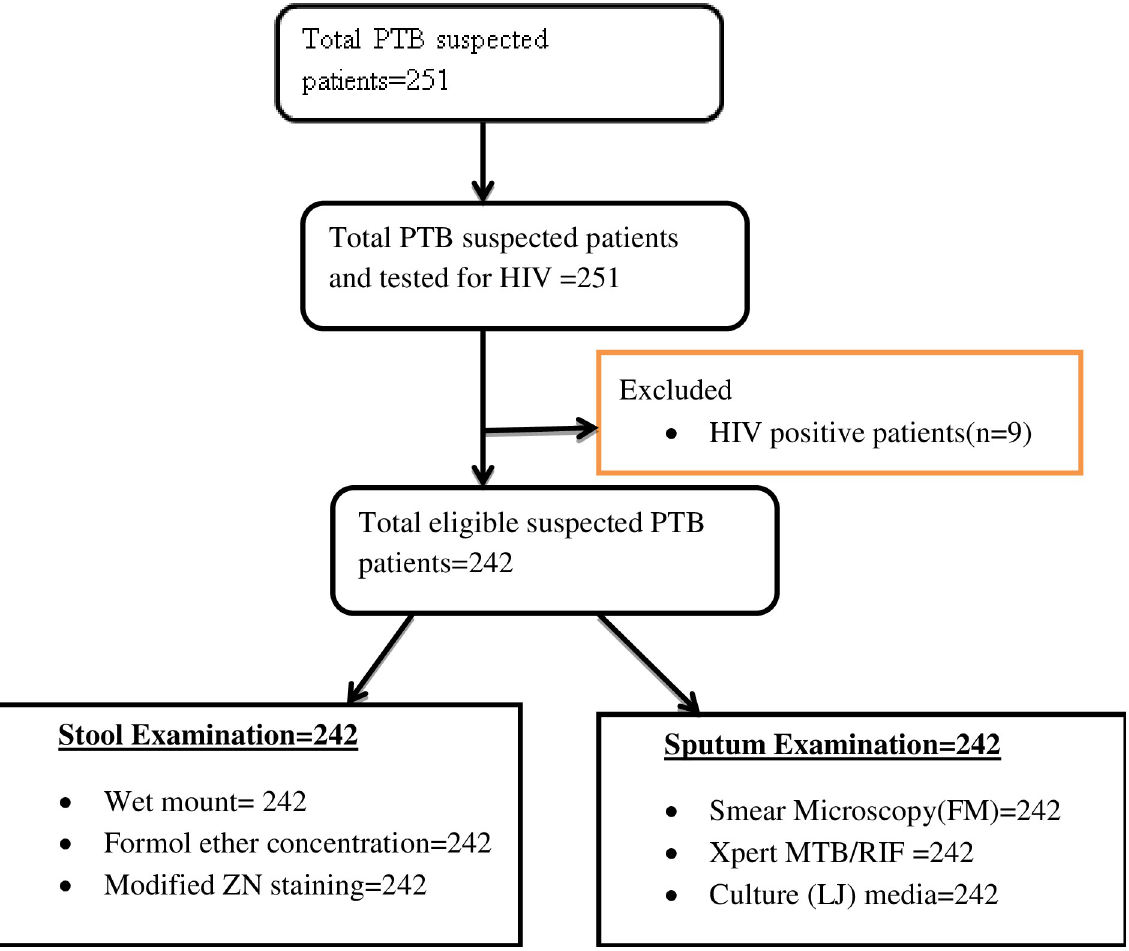
Fig 1. Flow chart for enrollment and data collection procedure for PTB suspected patients in Kuyu General Hospital, Ethiopia, 2020.